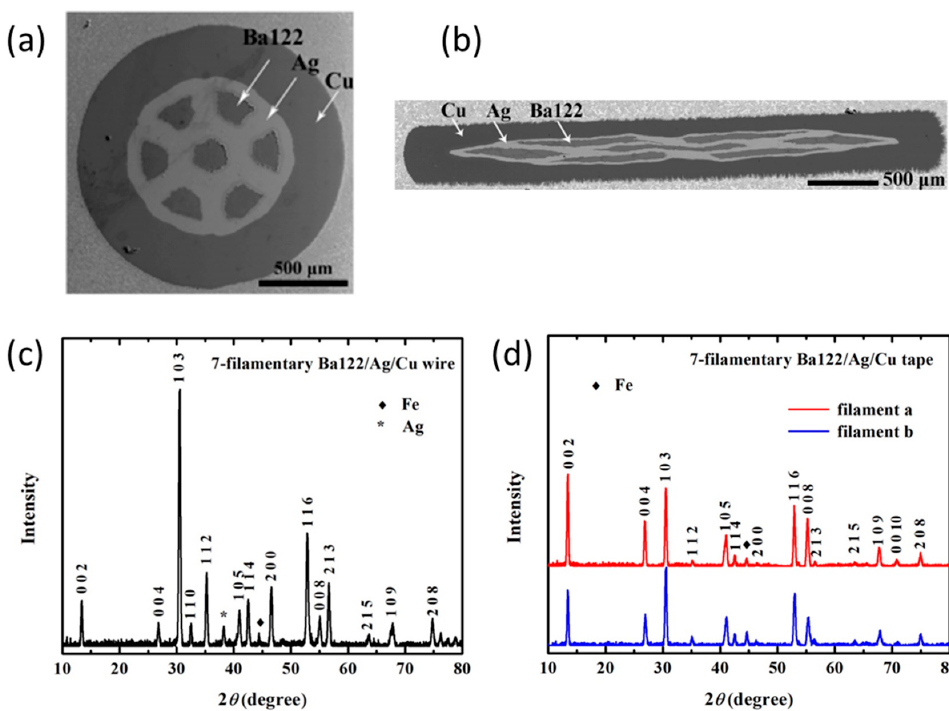
Figure 16. HIP-processed seven-filament (Ba,K)Fe 2 As 2 superconducting wires and tapes. ( a ) SEM image of a cross section of the wire; ( b ) SEM image of a cross section of the tape; ( c ) XRD pattern of the wire; ( d ) XRD pattern of the tape [61]. Adapted with permission from Ref. [61]. 2014, Elsevier.